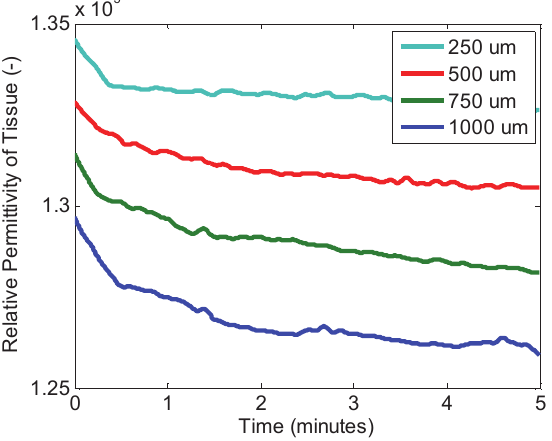
Fig. 13: Measured relative permittivity of acellular alginate during large strain indentation experiments calculated from eq. 33. Legend denotes final indentation depth.